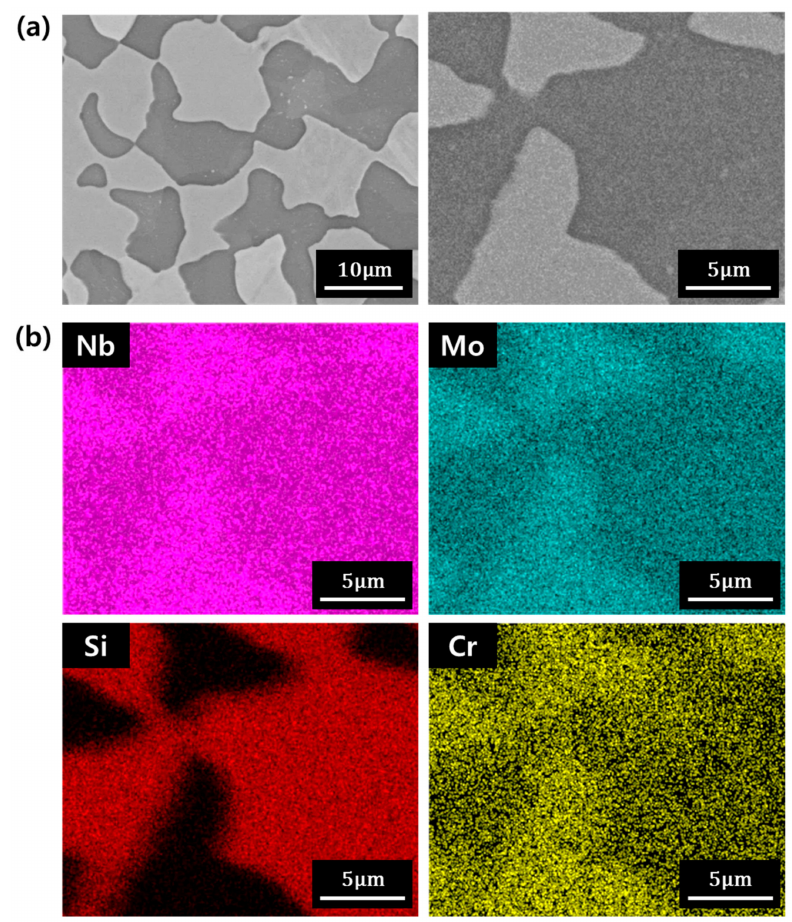
Figure 1. ( a ) Microstructure of the ingot observed via backscattered electron imaging. ( b ) EDS mapping results of the microstructure on the right side in Figure